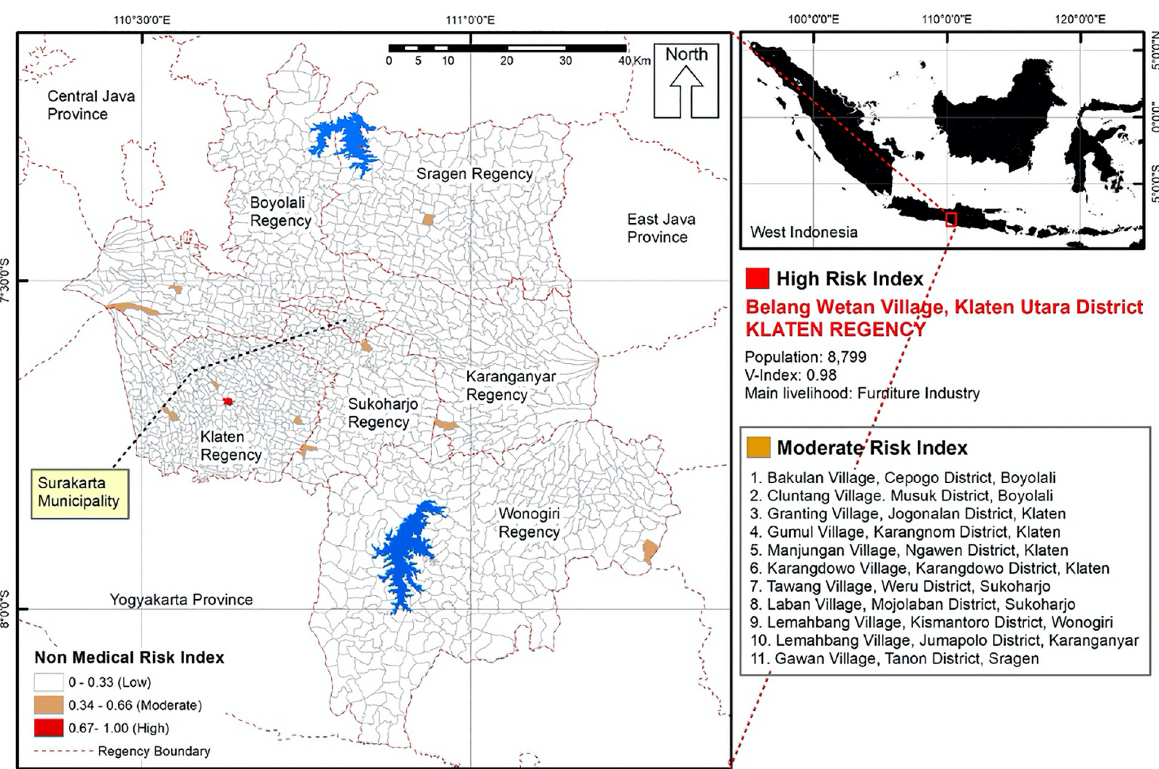
Fig. 11. Non-medical risk index in Greater